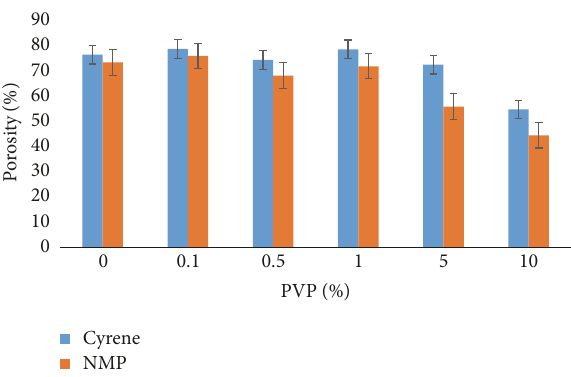
Figure 5: Overall porosity of the PES membranes prepared with Cyrene (cid:2) (blue) and NMP (orange).